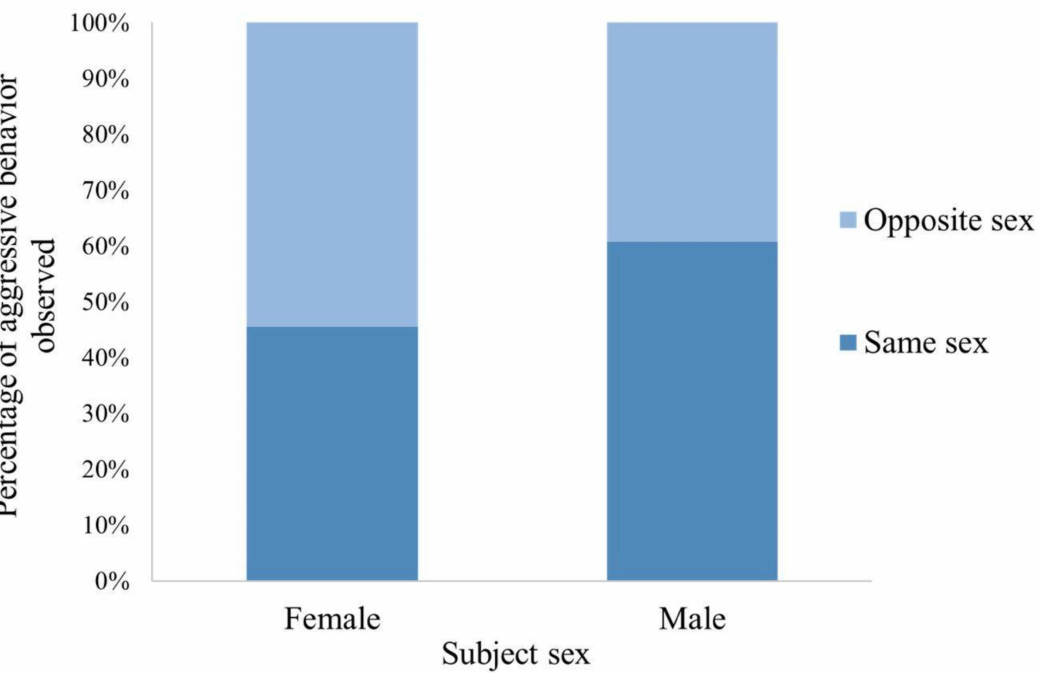
Figure 4. Percentage of aggressive behavior directed toward the same sex vs. opposite sex during social integration by the subject’s sex. More than half of male aggression was directed toward the same sex conspecifics (other males), while females directed aggression towards the opposite sex (males) more than the same sex